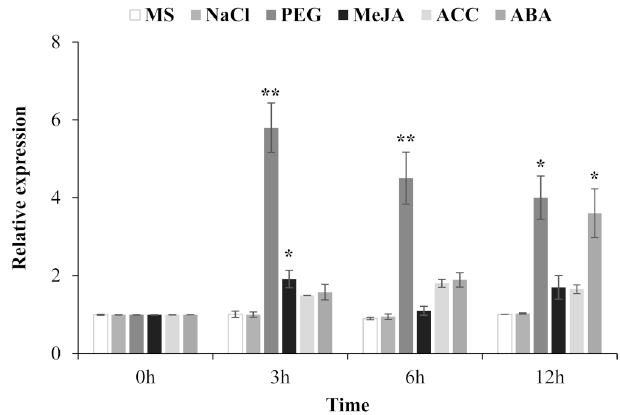
Figure 4. Expression profiles of TgEREF1 in response to ionic saline (NaCl) and non-ionic osmotic (PEG) stresses, and phytohormones in teak ( Tectona grandis ), as detected by RT-qPCR. Total RNA was isolated from leaves of two-month-old teak seedlings that were sampled after exposure to 150 mM NaCl, 20% PEG, 100 µ M MeJA, 100 µ M ACC, and 100 µ M ABA. Controls consisted of teak seedlings incubated on MS culture medium. Values correspond to the means ± standard error of the mean of three biological replicates. * p < 0.05 and ** p <